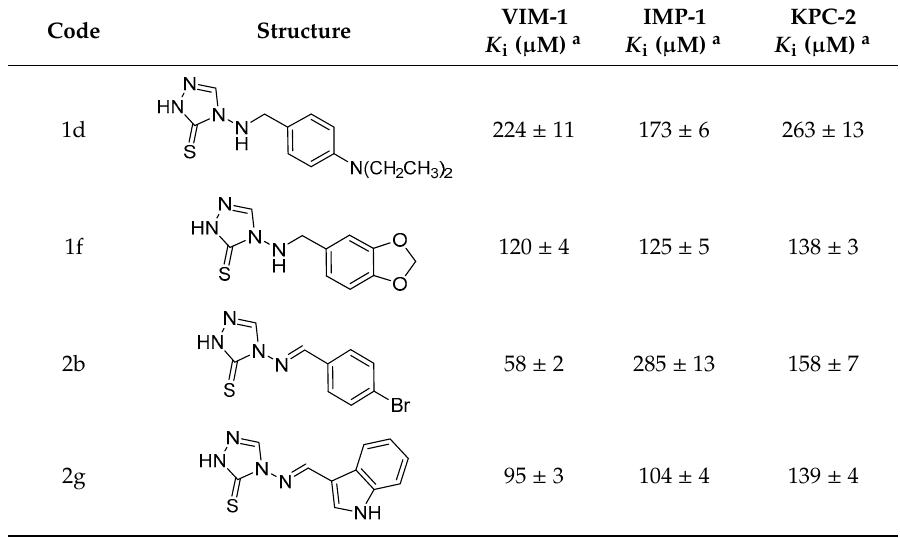
Table 1. Binding a ffi nity of the most promising broad-spectrum inhibitors against VIM-1, IMP-1 Table 1. Binding affinity of the most promising broad-spectrum inhibitors against VIM-1, IMP-1 and Table 1. Binding affinity of the most promising broad-spectrum inhibitors against VIM-1, IMP-1 and and KPC-2. Table 1. Binding affinity of the most promising broad-spectrum inhibitors against VIM-1, IMP-1 and Table 1. Binding affinity of the most promising broad-spectrum inhibitors against VIM-1, IMP-1 and KPC-2. KPC-2. KPC-2.